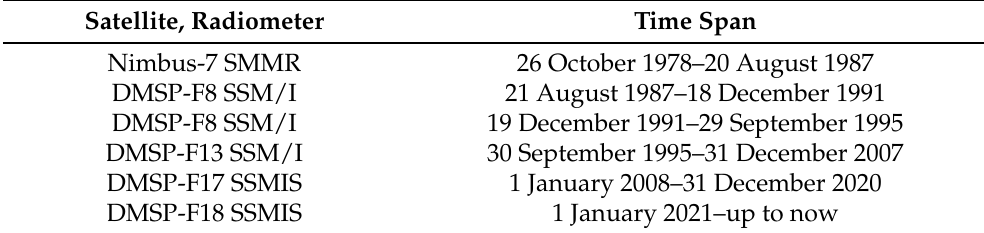
Table 1. Radiometers and satellites used in several time